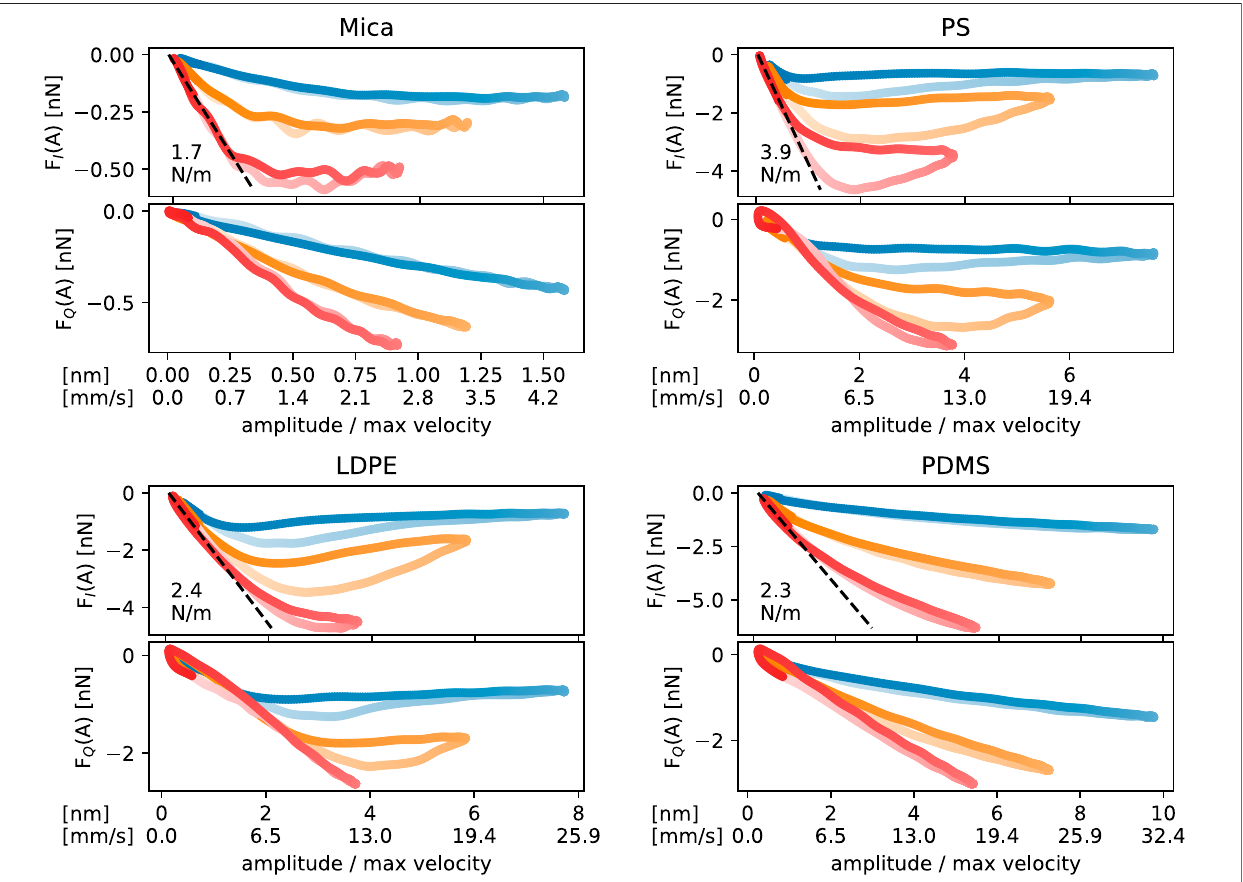
FIGURE3| Forcequadraturecurvesonmica.Theconservativeforcequadrature F I andthedissipativeforcequadrature F Q atrepresentativepixelsareplottedasa function of the amplitude A of tip motion or maximum velocity v max (cid:1) A ω 0 . From blue → orange → red, the load force isincreasing, controlled by the scanning feedback setpoint.HysteresisisseenforPSandLDPE,wheretheforcequadraturesarelargerforincreasing A (lightershade)thanfordecreasing A (darkershade).Weexplainthis hysteresis as a viscoelastic effect due to the relaxation time of the surface deformation being longer than the period of tip oscillation.